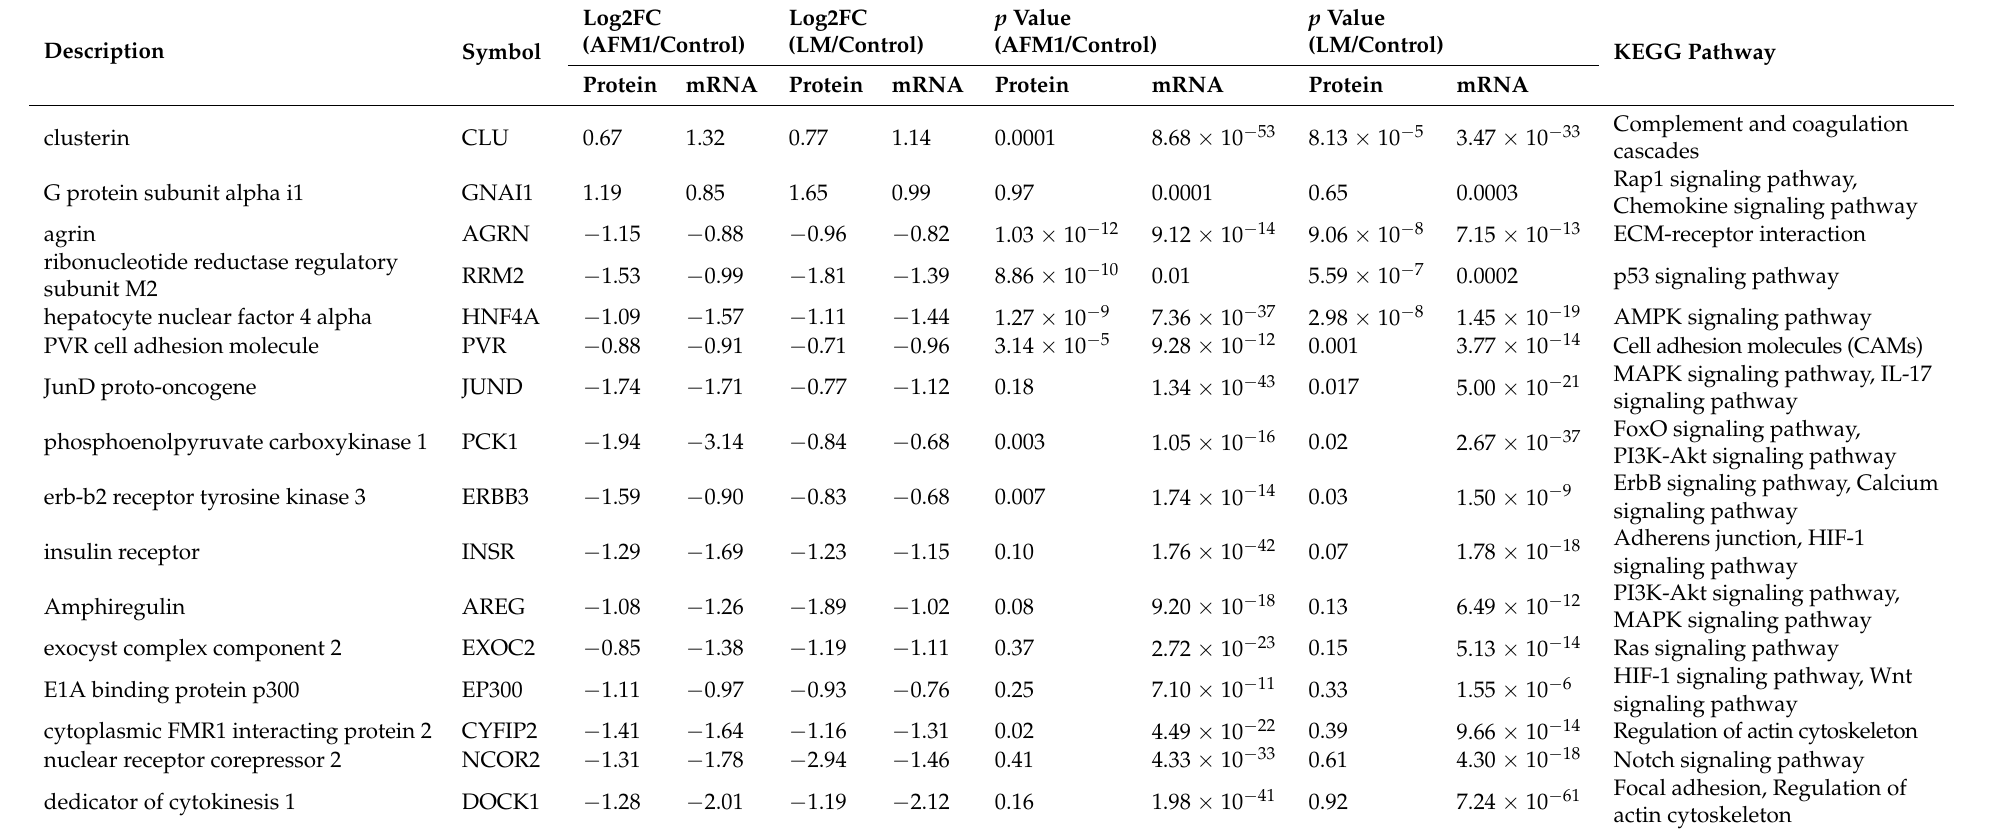
Table 1. Correlation between DEGs and DEPs in the differentiated Caco-2 cells exposed to AFM1 and LF + AFM1